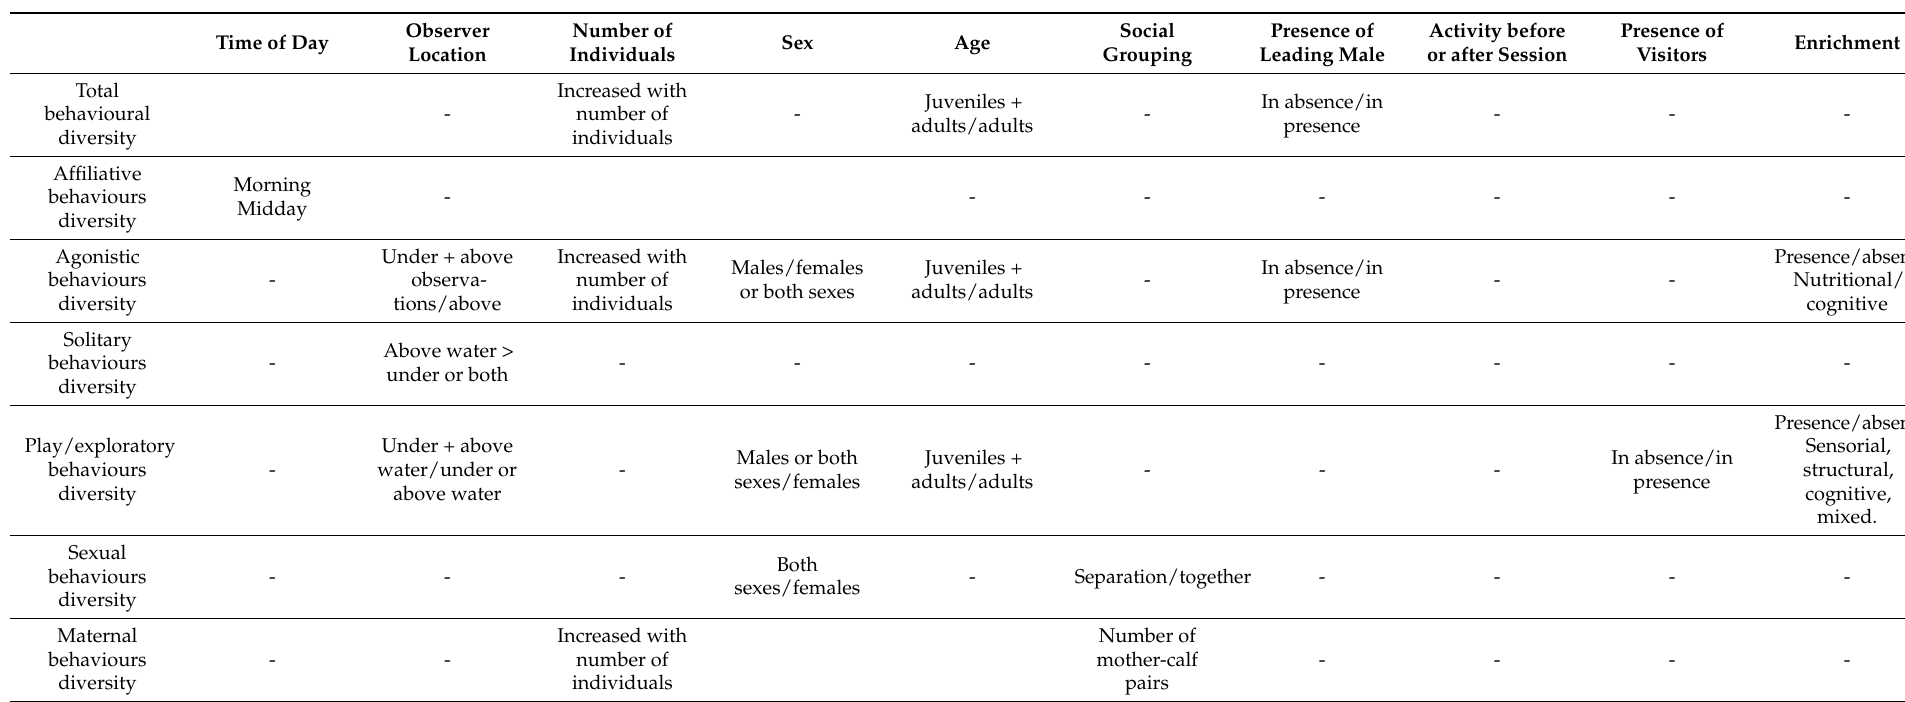
Table 2. Summary of impacts of predictors (top row) on functional behavioural categories (left column). Factors associated with significantly higher behavioural diversity are